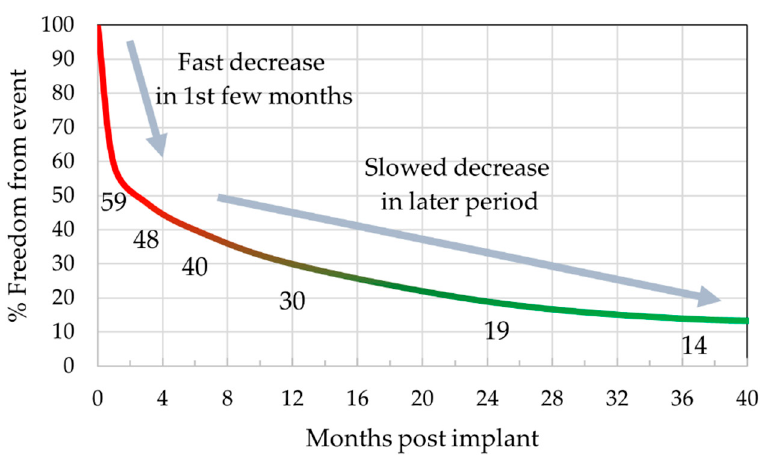
Figure 1. Freedom from postoperative VADs failure in the function of time based on literature data [16] .